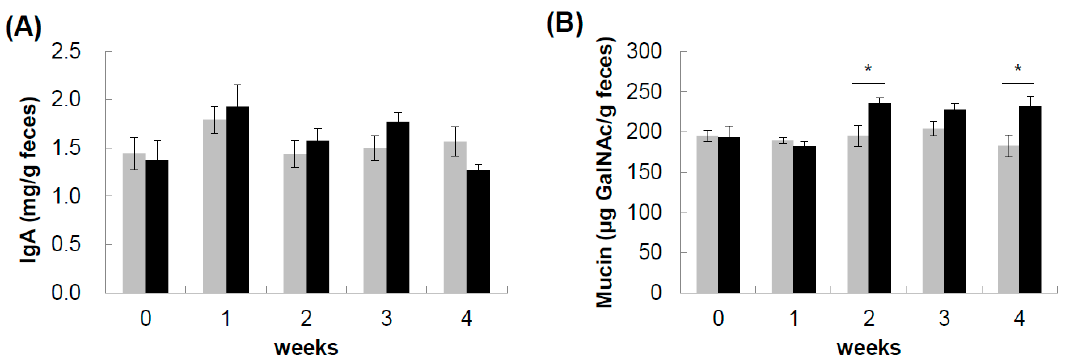
Figure 1. Fecal IgA and mucin contents. Feces from mice fed a control diet (control, gray bar) or a diet with sake cake and rice malt (SRP, black bar) were collected every week during four weeks of feeding. ( A ) IgA contents and ( B ) mucin contents in feces were measured. Data are shown as the mean ± SEM ( n = 7). * p < 0.05.